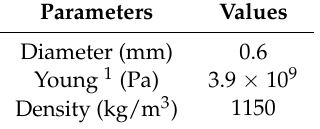
Table 2. Cable parameters.